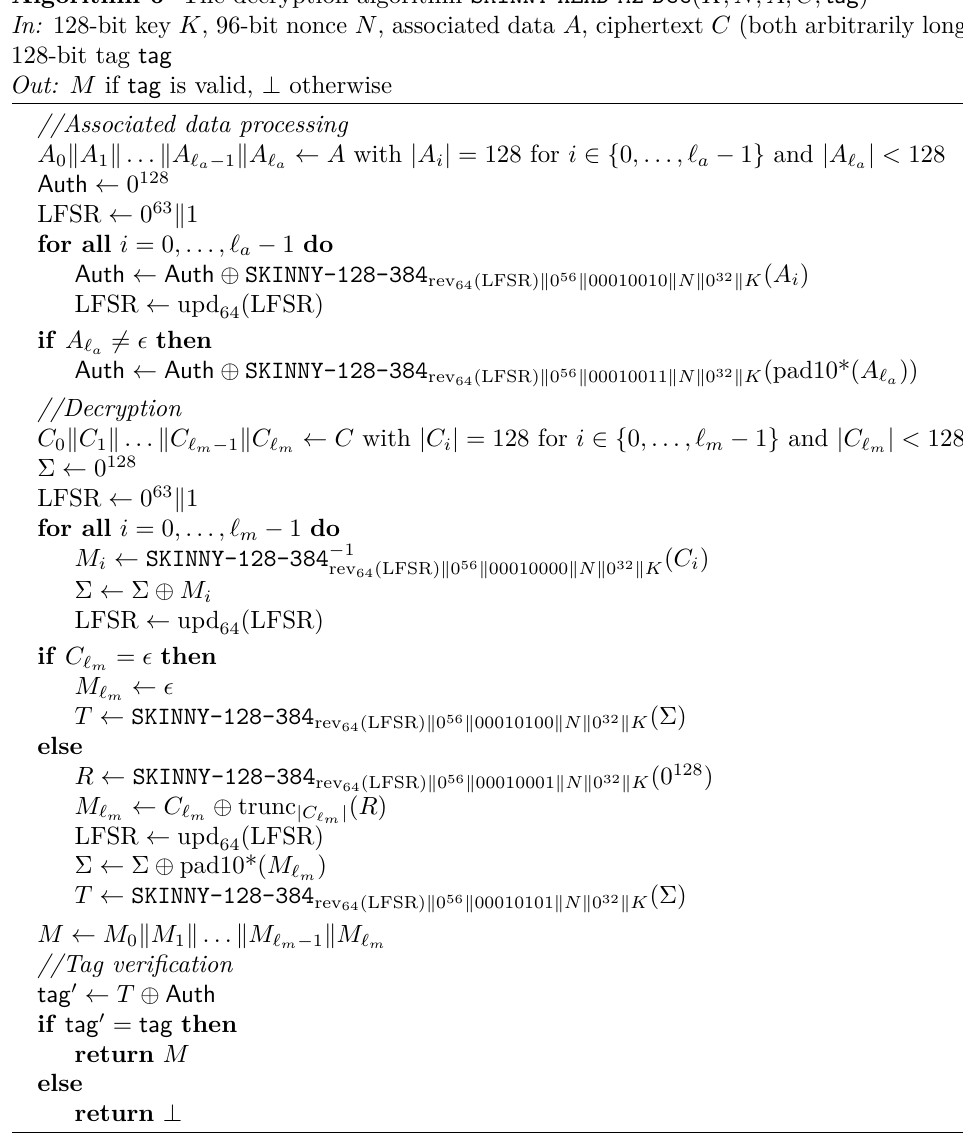
Algorithm 6 The decryption algorithm SKINNY - AEAD - M2 - Dec ( K, N, A, C, tag